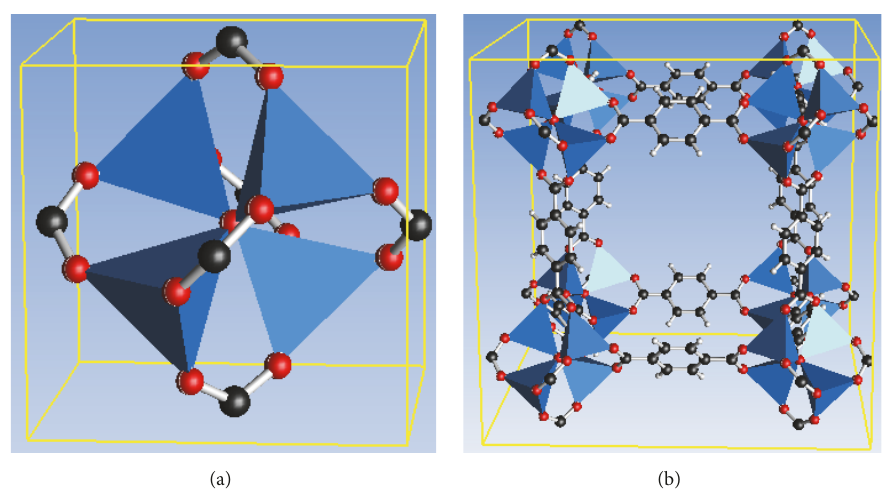
Figure 8: Template based modeling for MOFs.